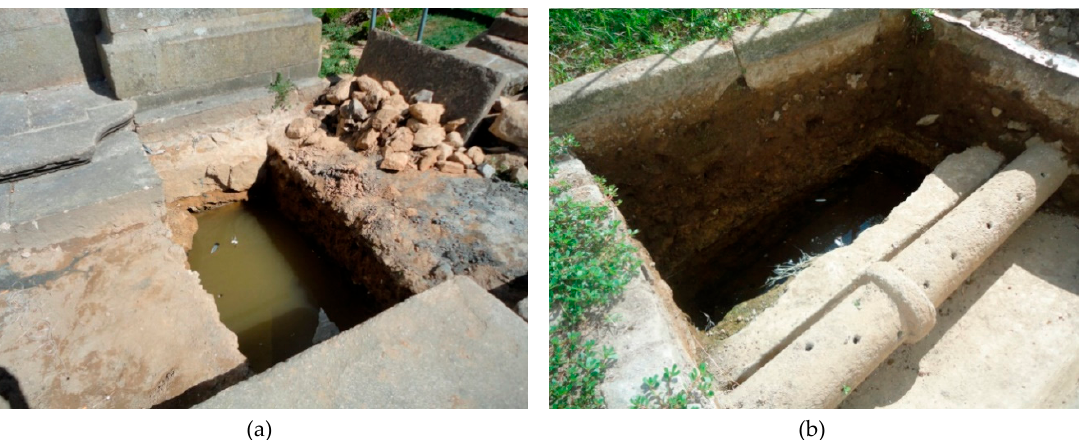
Figure 6. Water table visible in the inspection trenches days after the excavation (summer period). ( a ) Excavation 1: water level at − 0.93 m below the nave floor; ( b ) Excavation 3: water table at − 1.10 m measured from the floor of the nave.